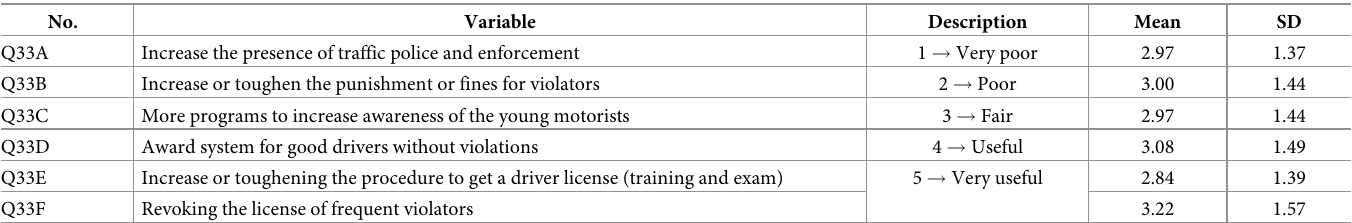
Table 2. Descriptive statistics for the proposed